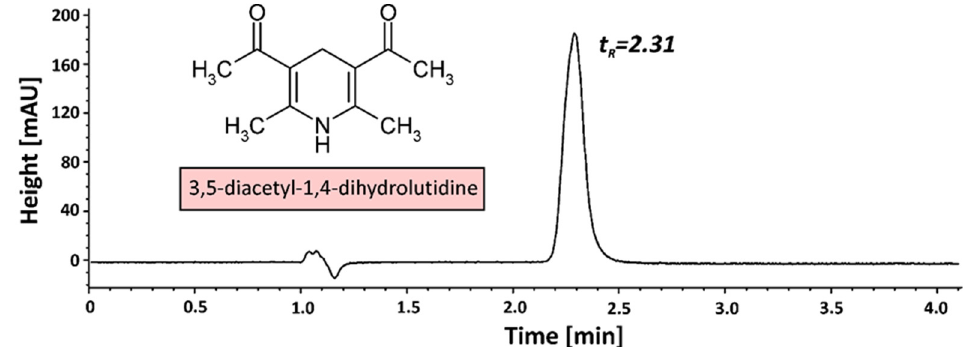
Figure 8. A chromatogram of a standard solution of formaldehyde derivative.